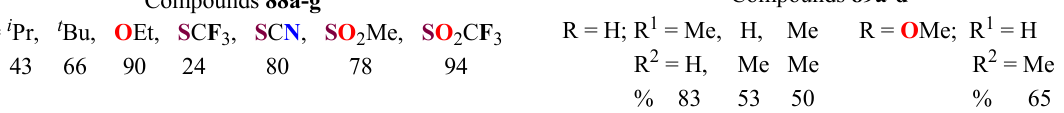
Figure 11. The 6-substituted-arylUBTs 87a – l , 88a – g , and 89a – d from CDI and the corresponding substituted aniline.